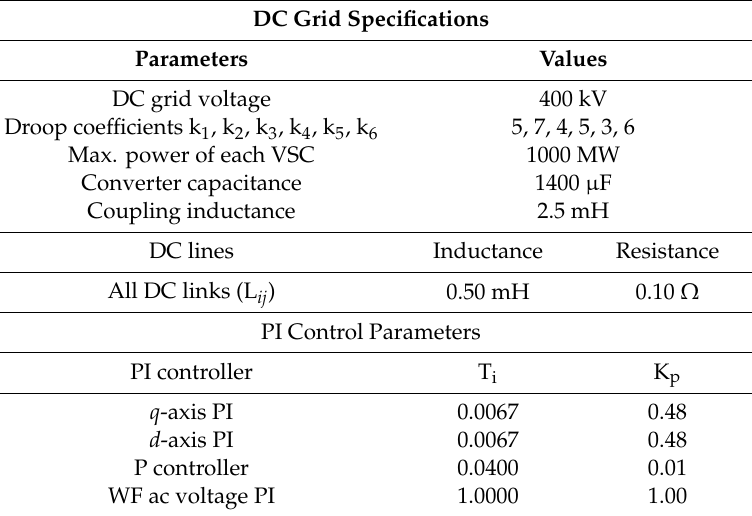
Table 1. Control parameters and systems specifications.